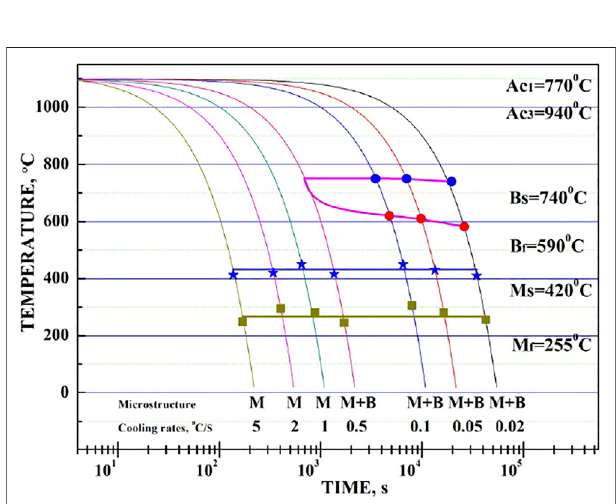
FIGURE 7 | Results of 0.5 ° C/s cooling rate specimen, (A) the CCT expansion curve, (B) the microstructure.